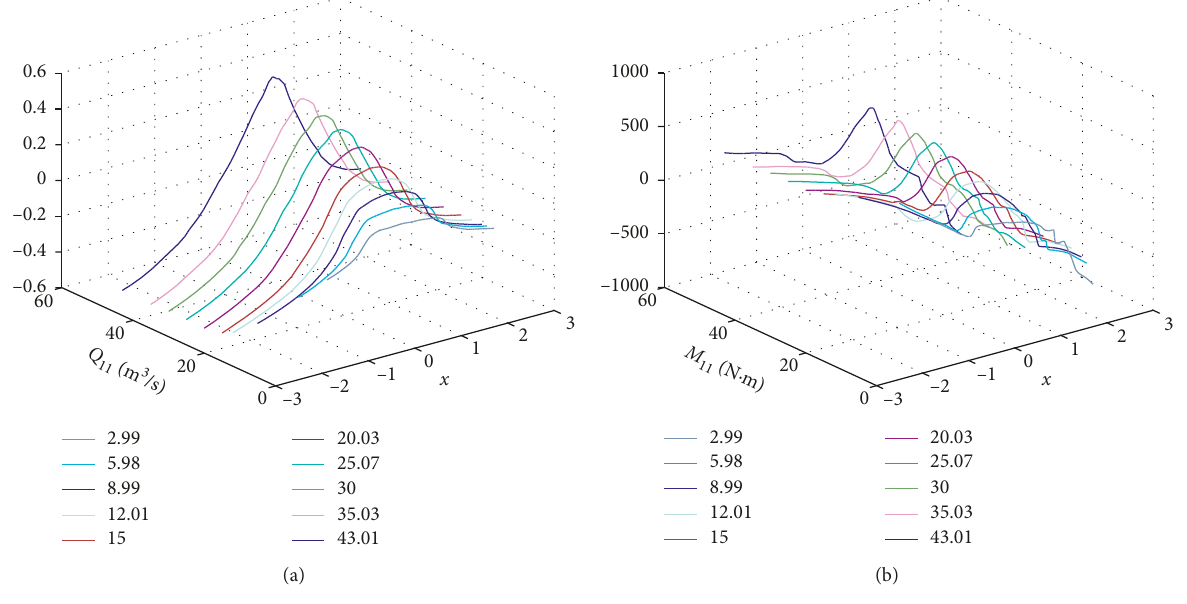
Figure 2: Logarithmic curve projection of the characteristic